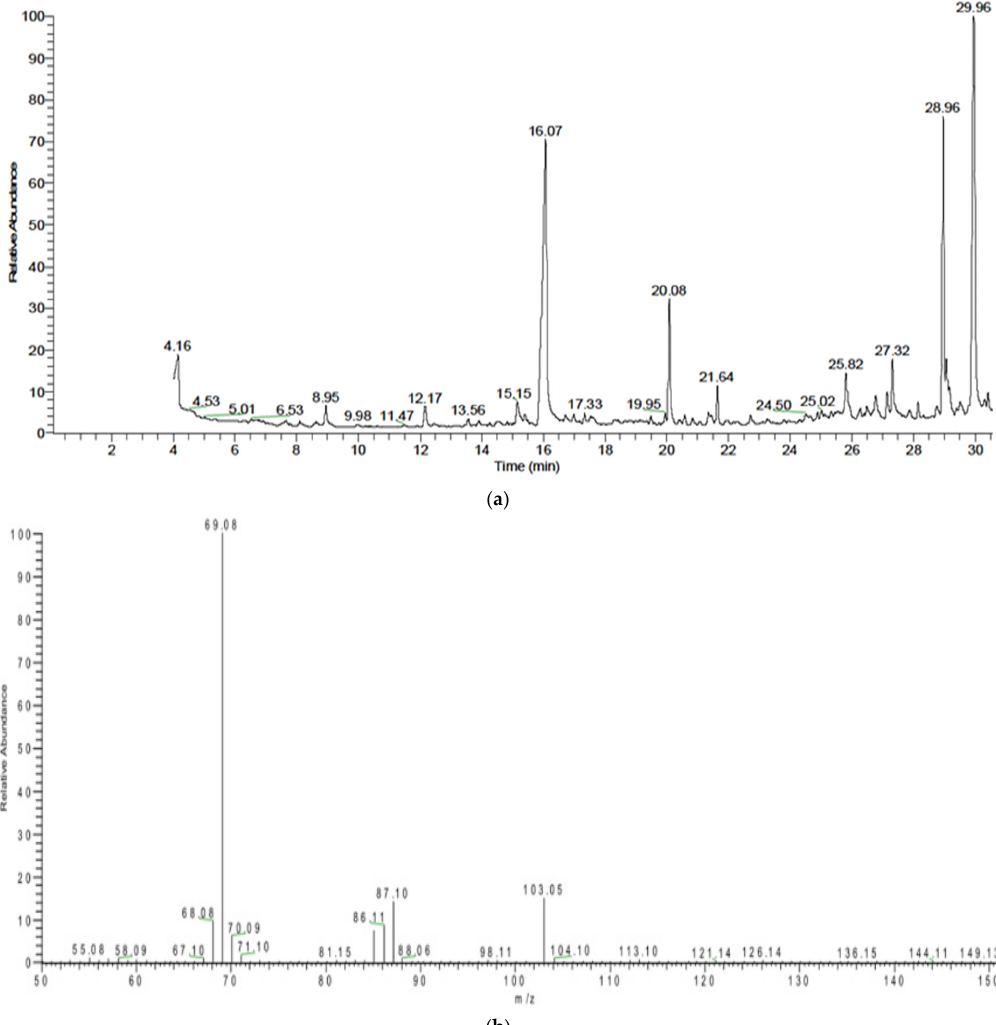
Figure 4. ( a ): Total GC-MS chromatogram of PHB extracted from Azotobacter salinestris . ( b ): The mass spectrum of isopropyl ester of 2-butenoic acid of PHB extracted from Azotobacter salinestris .